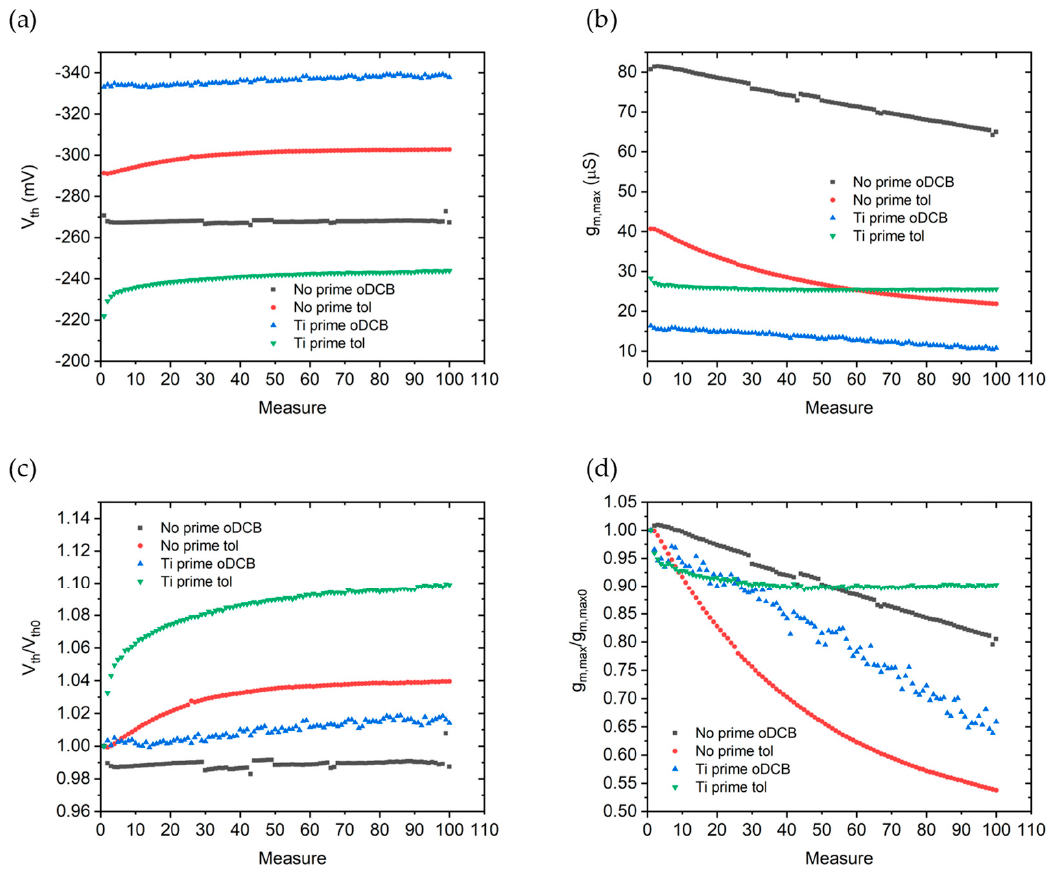
Figure 8. Threshold voltages ( a ) and maximum transconductances ( b ) extracted from 100 repeated I ds vs V gs curves, measured at a scan rate = 40 mV / s. ( c ) Threshold voltages and ( d ) maximum transconductances normalized with respect to the first measurement.